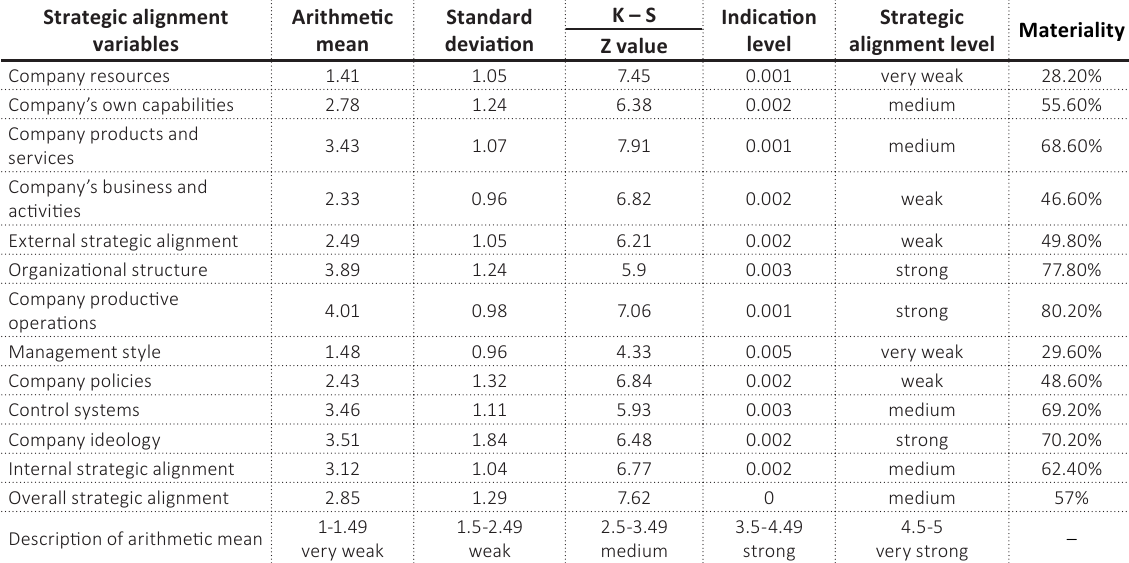
Table 5. The level of strategic alignment from a research sample perspective